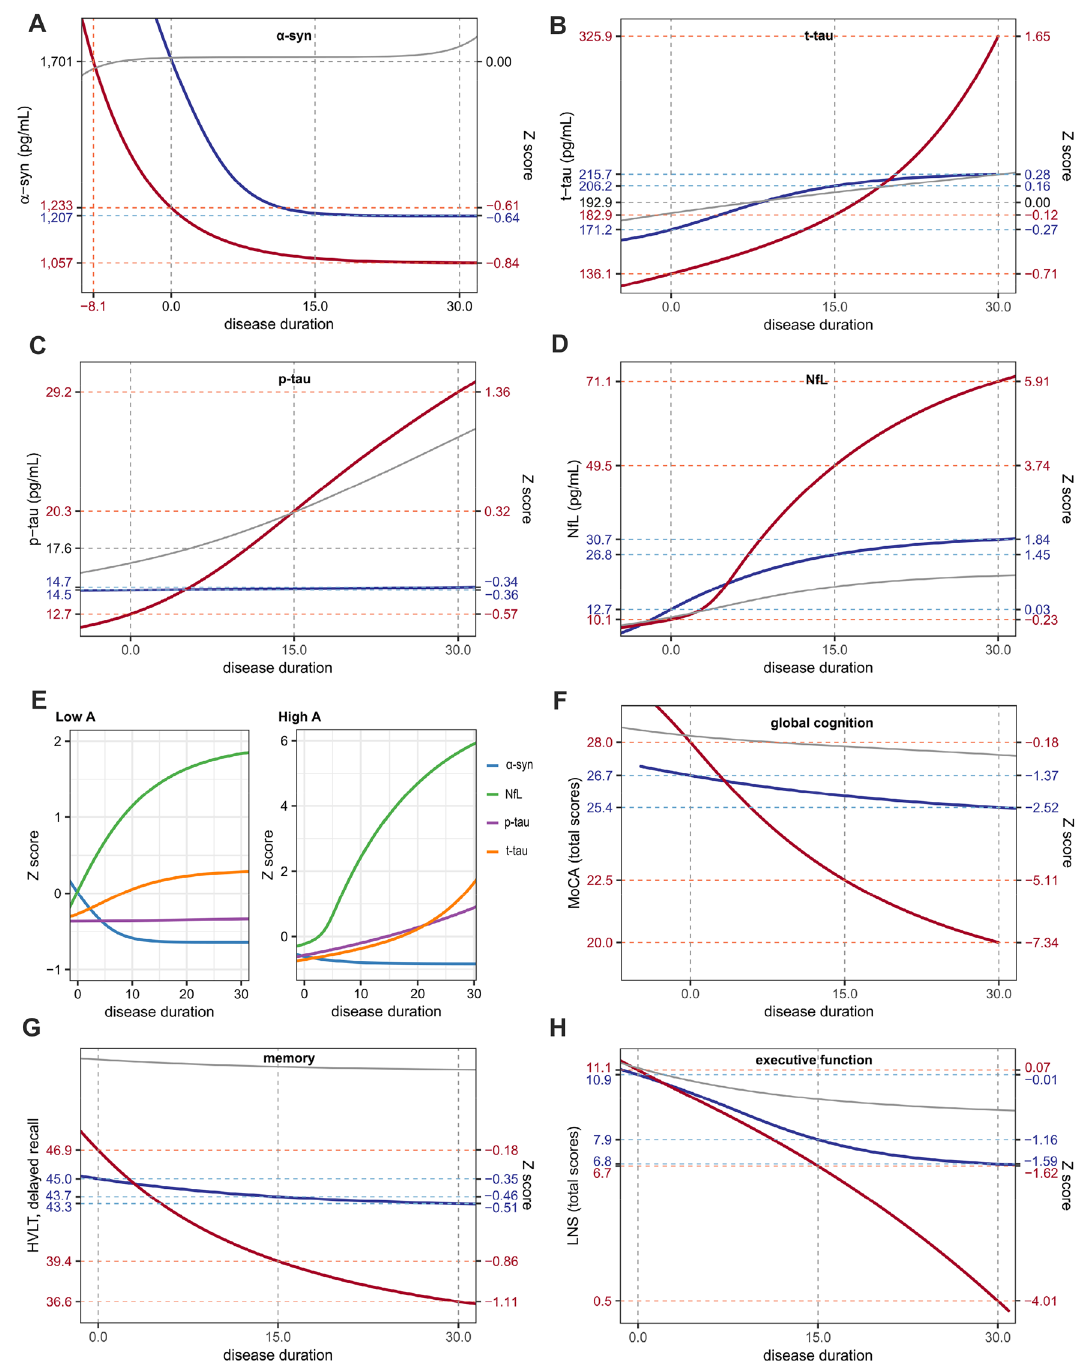
Figure 4. Temporal trajectories of biomarkers and cognitive performances in PD patients with high and low CSF Aβ 1-42 at baseline. PD patients with low CSF Aβ 1-42 levels (red lines) show greater change in four biomarkers ( A : α-syn, B : t-tau, C : p-tau, D : NfL) and cognitive decline ( F : global cognition, G : memory, H: executive function) across the disease course than those with high CSF Aβ 1-42 (blue lines). NfL showed the greater changes in the temporal trajectory among biomarkers ( E ). Gray lines represent temporal trajectories in control group. Figures are illustrated using ggplot2 and patchwork packages in R software. α-syn α-synuclein; t-tau total tau; p-tau phosphorylated tau; NfL neurofilament light chain; MoCA Montreal Cognitive Assessment; LNS Letter- Number Sequencing test; HVLT Hopkins Verbal Learning